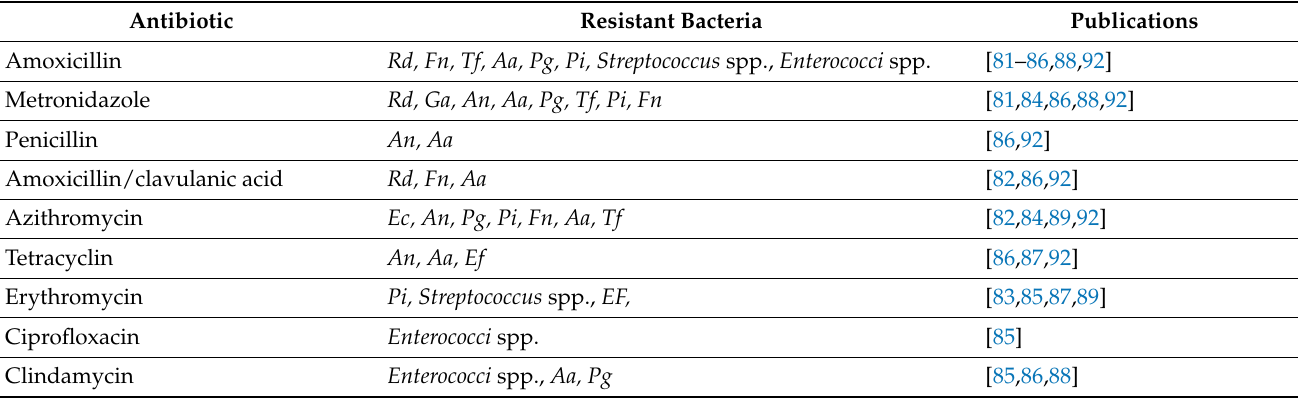
Table 2. Summary of observational studies for resistance pattern of subgingival biofilm bacteria against common antibiotics in periodontal health and